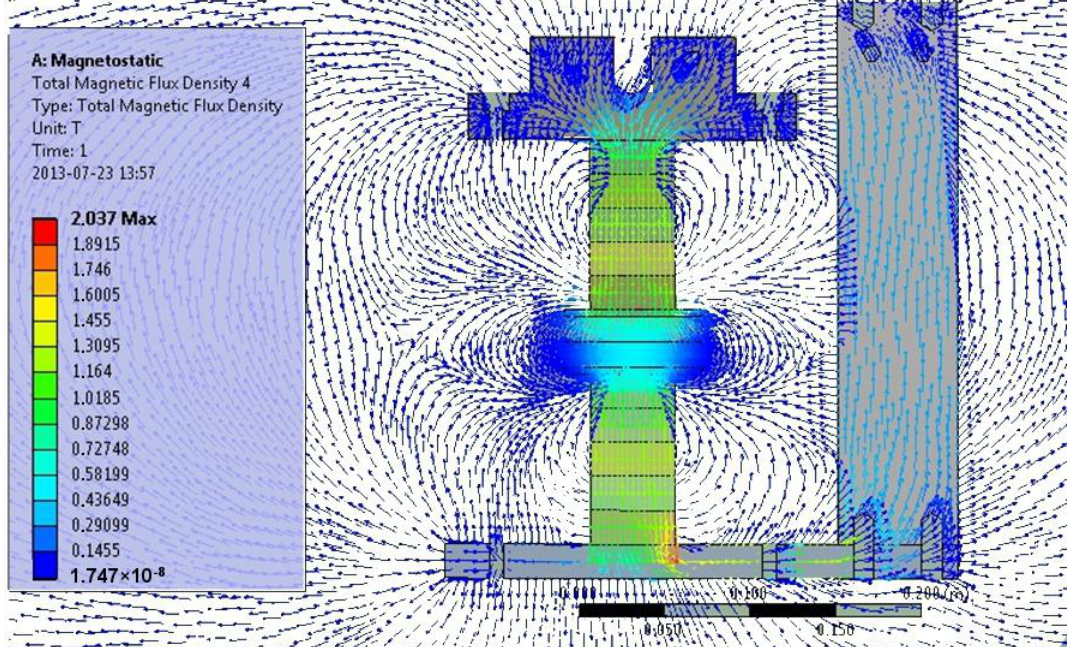
Figure 10. Vector image of the distribution of magnetic lines in a cross section.